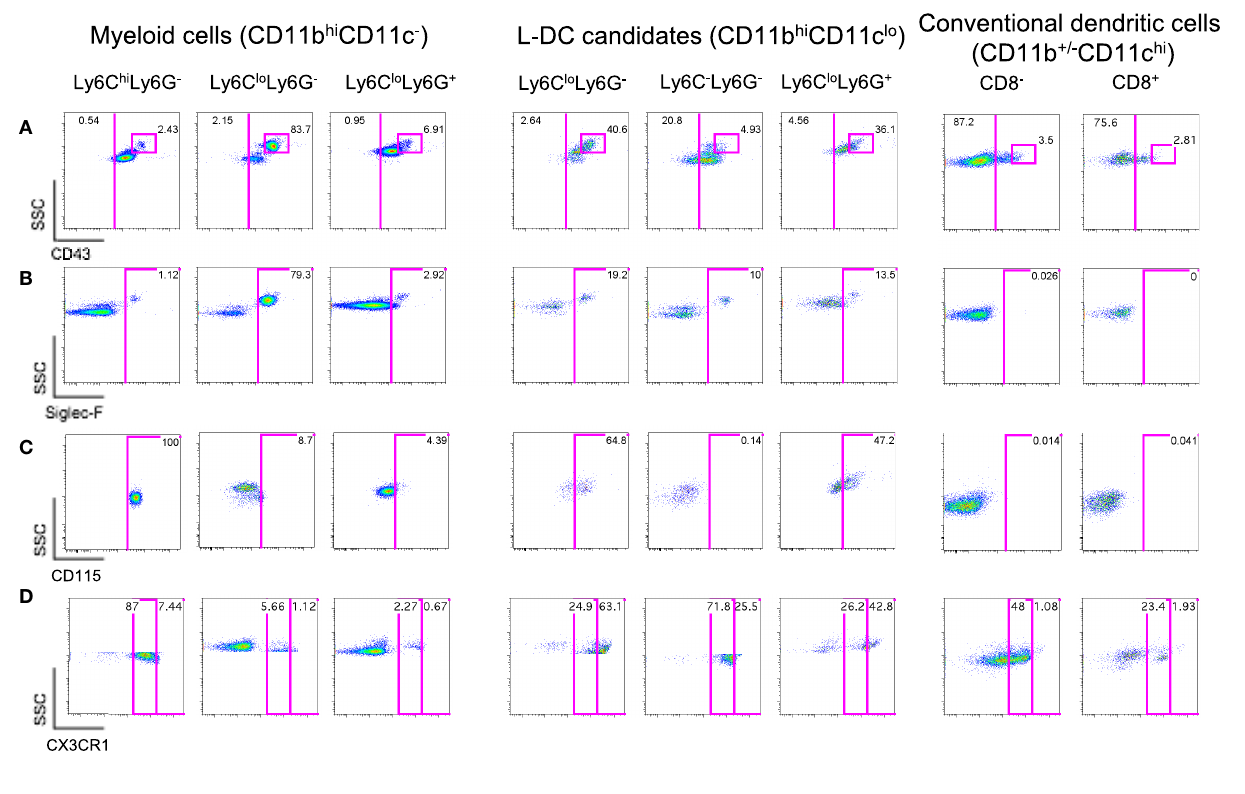
FigUre 2 | Further delineation of myeloid cells on the basis of cD43, siglec-F, and cD115 expression . Spleen cells were prepared and stained as described in Figure 1 with the addition of antibodies specific for CD43, CD115, Siglec-F, and CX3CR1. Live (PI − ) cells were gated as myeloid cells (CD11b hi CD11c − ) and L-DC candidates (CD11b hi CD11c lo ). Myeloid cells were further divided to reveal Ly6C hi Ly6G − , Ly6C lo Ly6G − , and Ly6C lo Ly6G + subsets. L-DC were further delineated as three candidate subsets differing in Ly6C and Ly6G expression. Expression of (a) CD43, (B) Siglec-F, (c) CD115, and (D) CX3CR1 was determined on all subsets. Gates were set based on fluorescence minus one control, and numbers in gates represent % specific